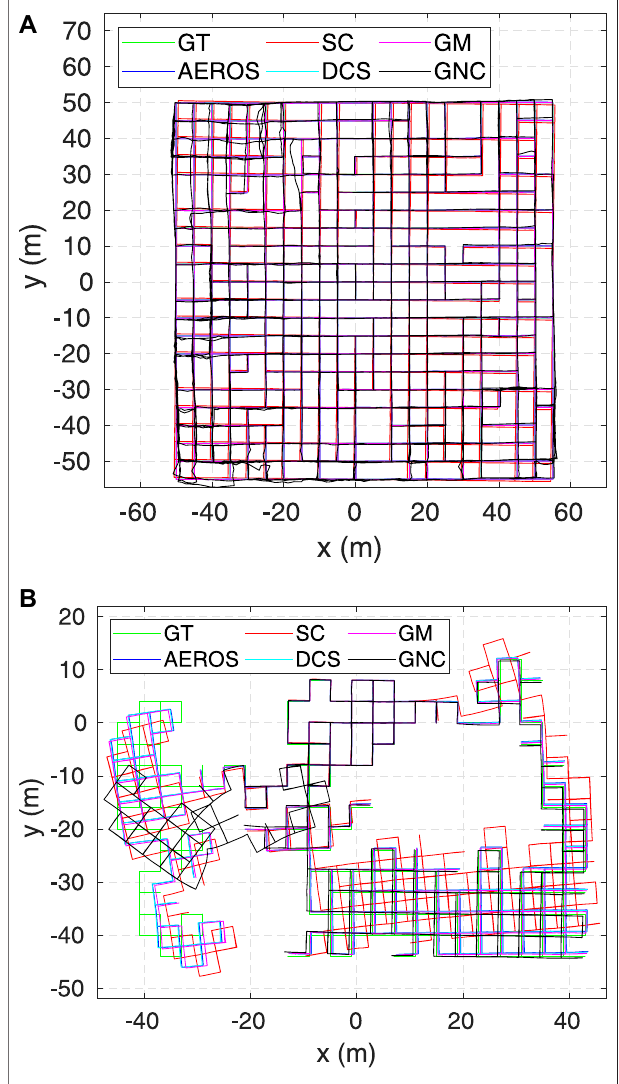
FIGURE4| EstimatedtrajectoriesfortheAEROSalgorithmcomparedto the SC, GM, DCS and GNC solutions as well as the ground truth for the City10000 (A) and Manhattan3500 (B) each with 10 % outlier